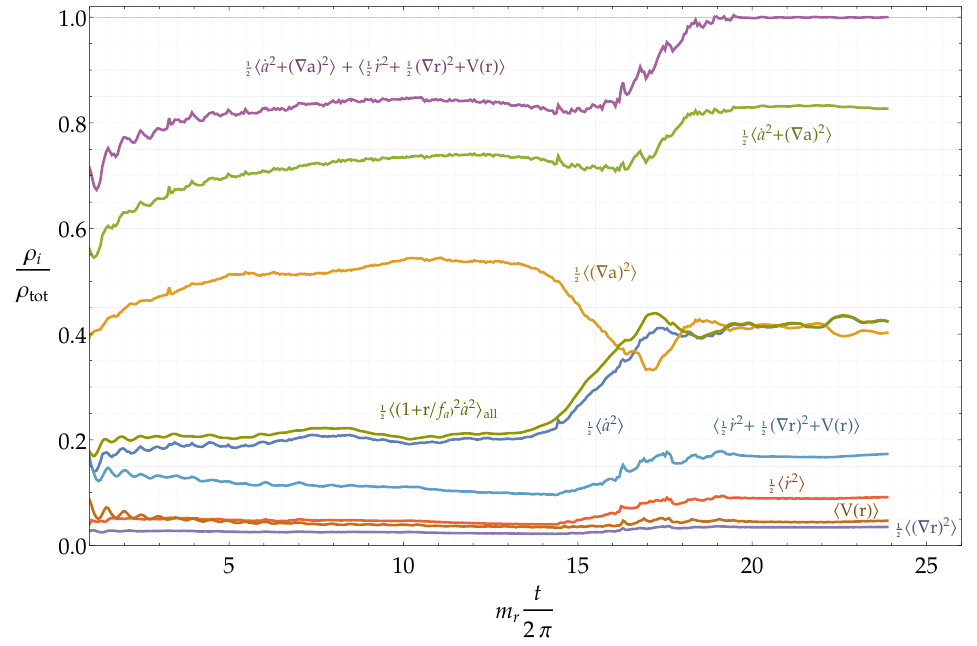
Figure 20 . Di(cid:11)erent contributions to the total energy density (cid:26) tot , each one normalised to (cid:26) tot , as a function of time for fat string system. All contributions are calculated as the spatial average at a distance d s = 1 from the strings’ center, except for 1 h (1 + r=f a ) 2 _ a 2 i , which is calculated over 2 the whole space. The string network begins to be destroyed by the (cid:12)nite box size at m r t= 2 (cid:25) (cid:24) 19, corresponding to the purple line going to